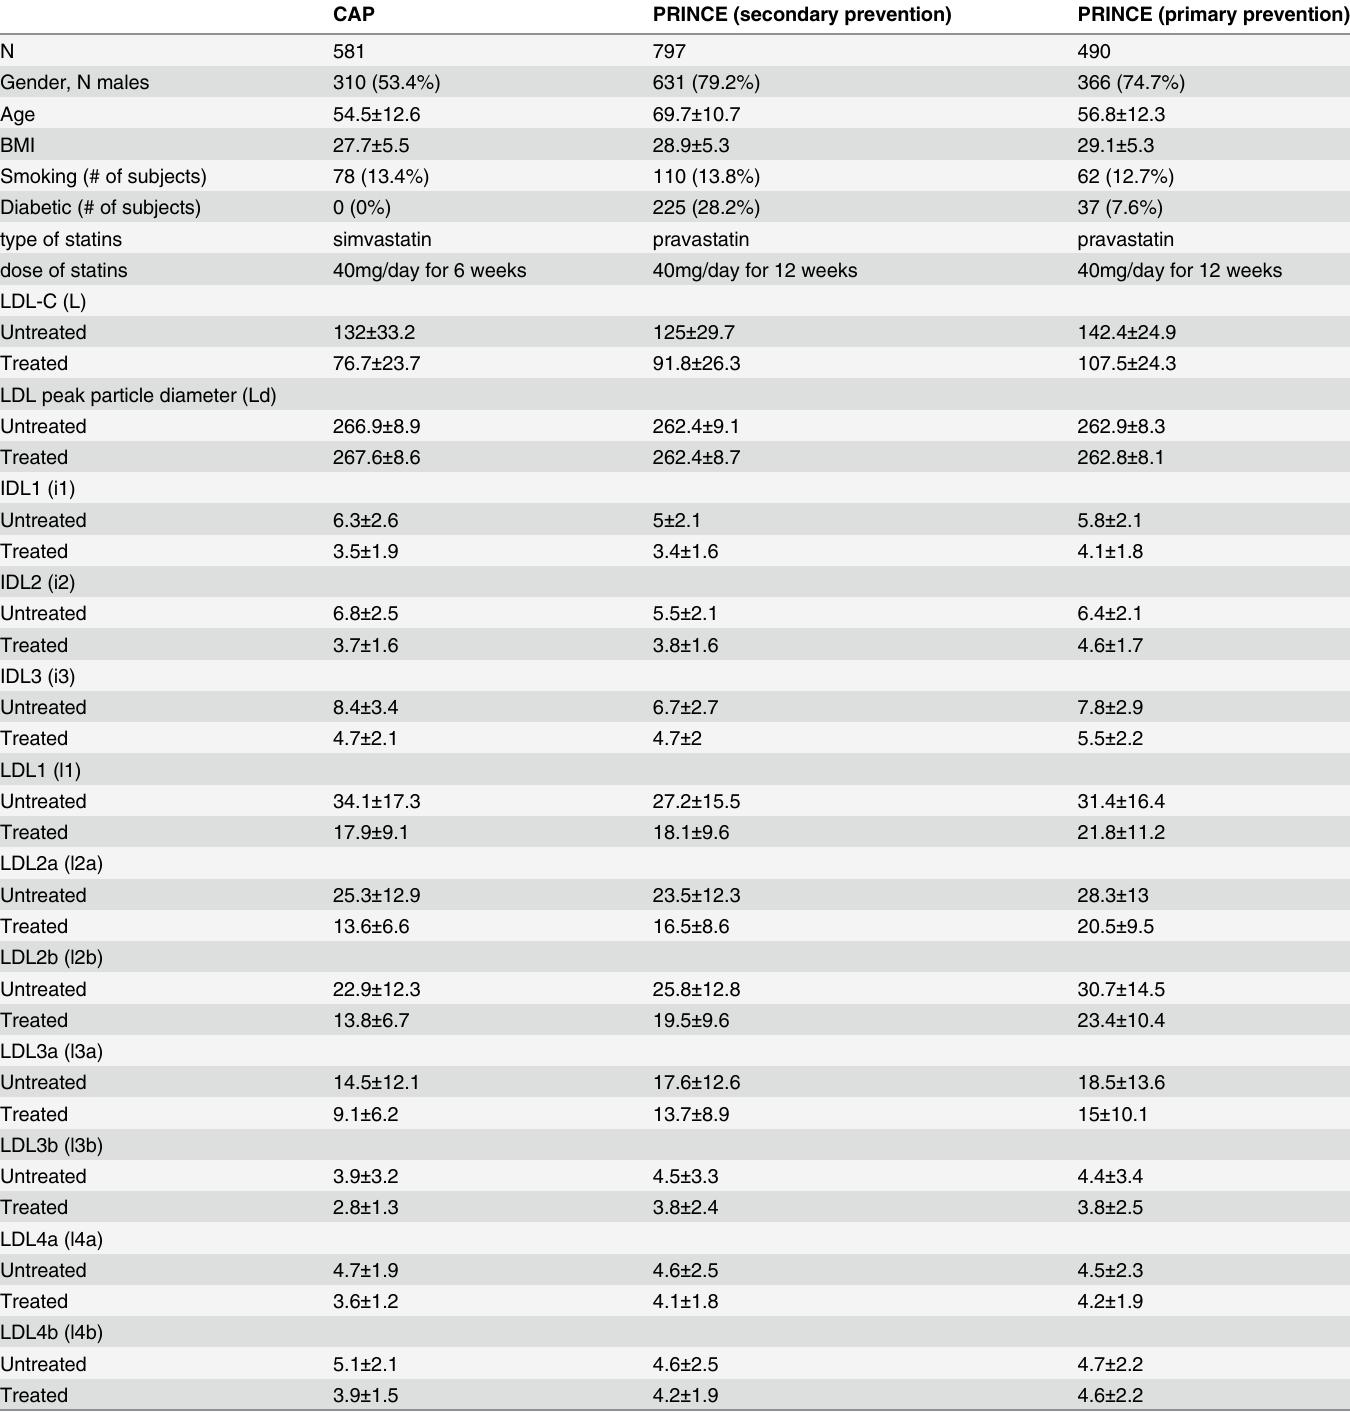
Table 1. Summary of phenotype distributions (mean ± standard deviation) for individuals in our analysis, stratified by